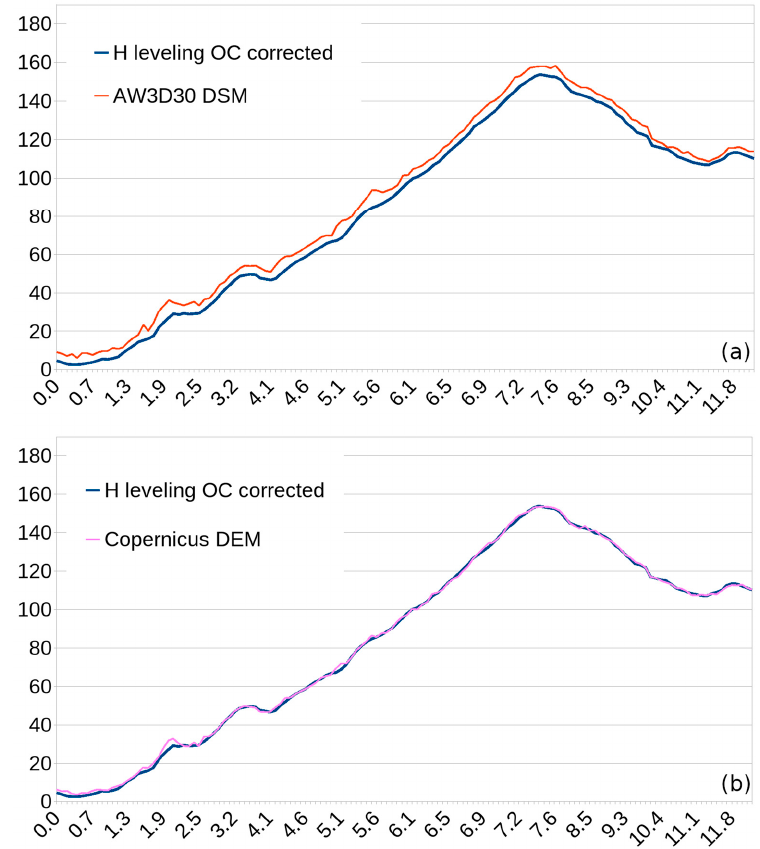
Figure 5. Height values along the traverse in Central Greece from ( a ) AW3D30 DSM (red line) and leveling and ( b ) Copernicus DEM (pink line) and leveling. ( x -axis: distance in km/ y -axis: height in m).